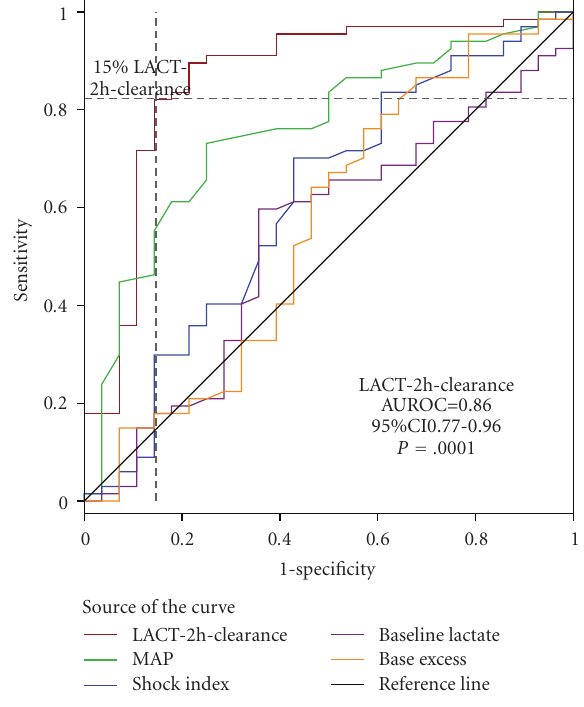
Figure 1: ROC curve for LACT-2h-clearance.